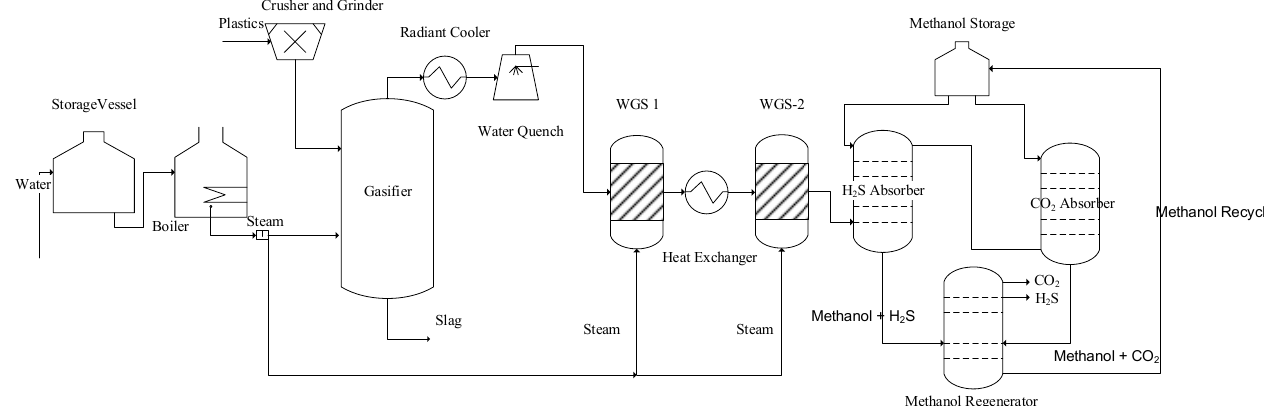
Figure 1. Hydrogen production from waste plastics: PE and PP (case 1).